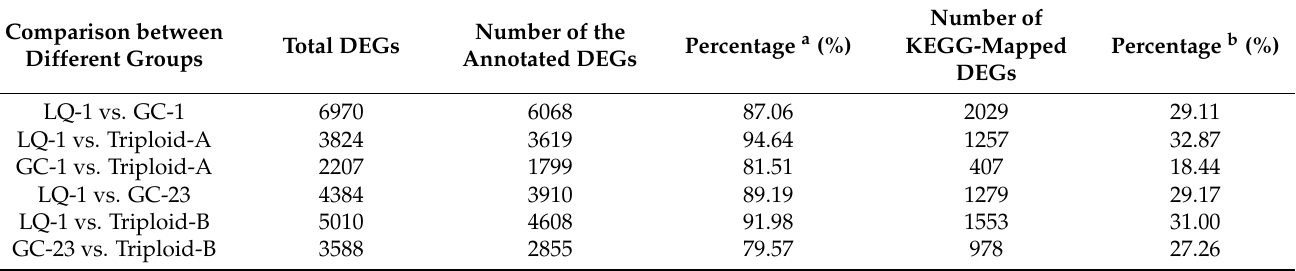
Table 2. Characteristics of the differentially expressed genes generated from the transcriptome analyses of the different comparative